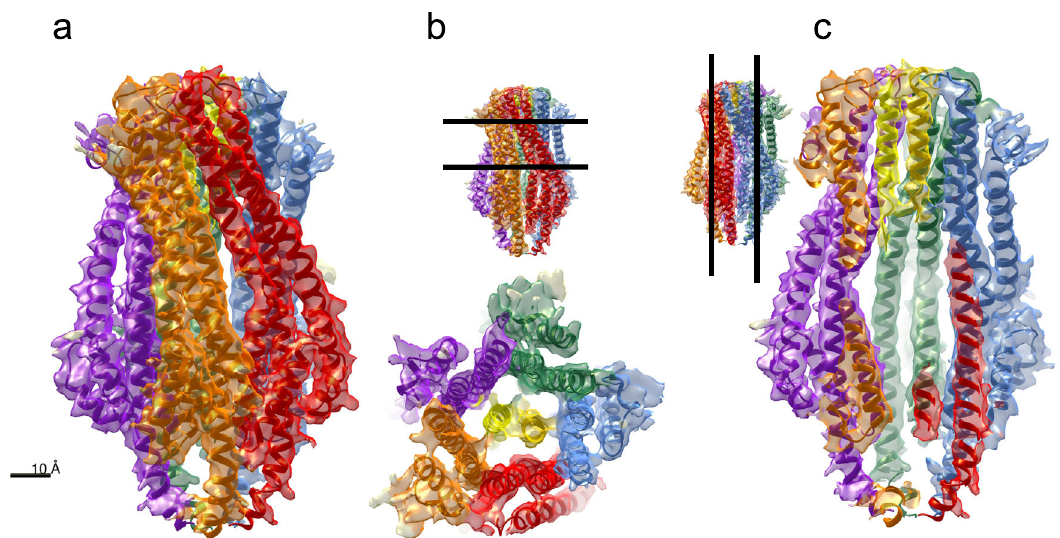
Fig. 7 Structure of ExbBD Sm solved by cryo-EM. The same color code as in Fig. 7 for is used the ExbB monomers and the two ExbD monomers are colored yellow and gold. a Side view. b View from the periplasmic space. c Clipped side view, with the helix of each ExbD monomer represented (yellow and gold). For ( b , c ), the insets show the clipping planes.